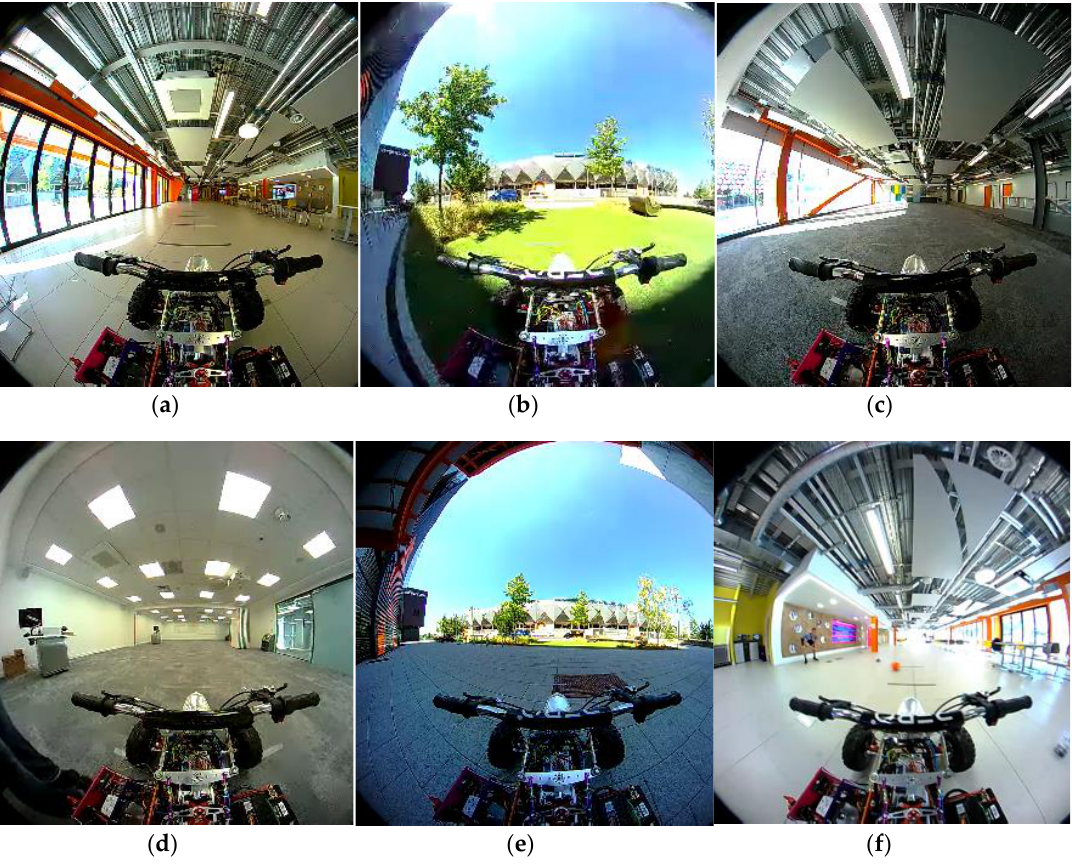
Figure 8. Screen shots of different scenarios captured by the quadbike in motion. ( a ) Scenario 1: Indoors tiled floor with cluttered environment; ( b ) Scenario 2: Outdoor environment on artificial grass; ( c ) Scenario 3: Indoor environment with carpet floor and extreme shadows; ( d ) Scenario 4: Indoor environment with less clutter; ( e ) Scenario 5: Outdoor environment with change of surface; ( f ) Scenario 6: Indoor environment with moving object in LiDAR blind spot.